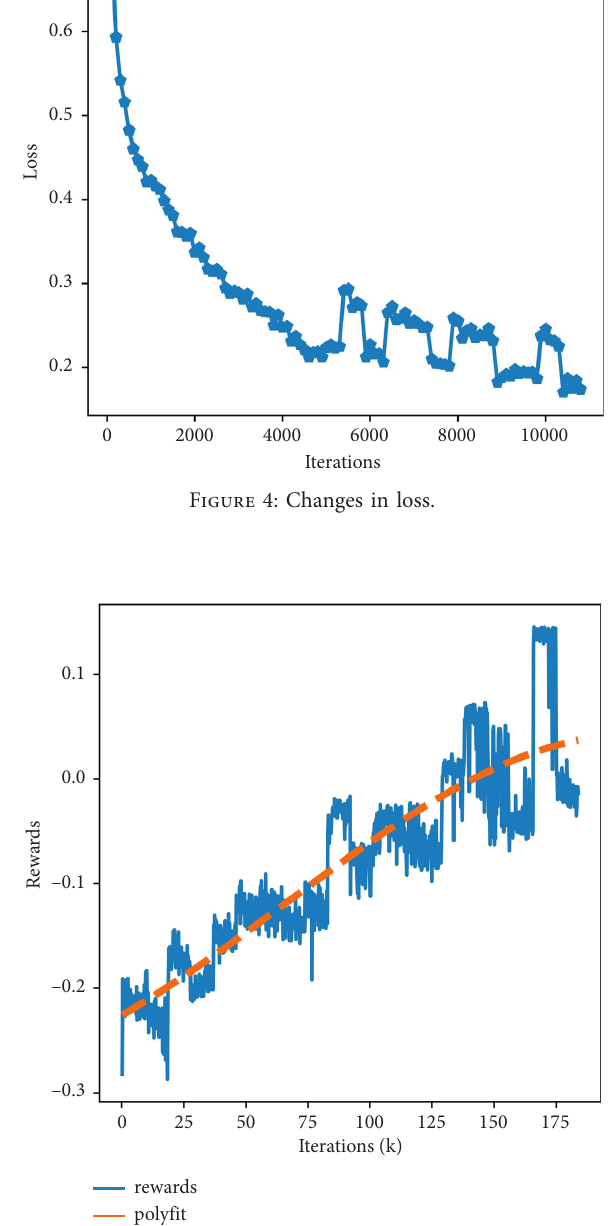
Figure 5: Reward during